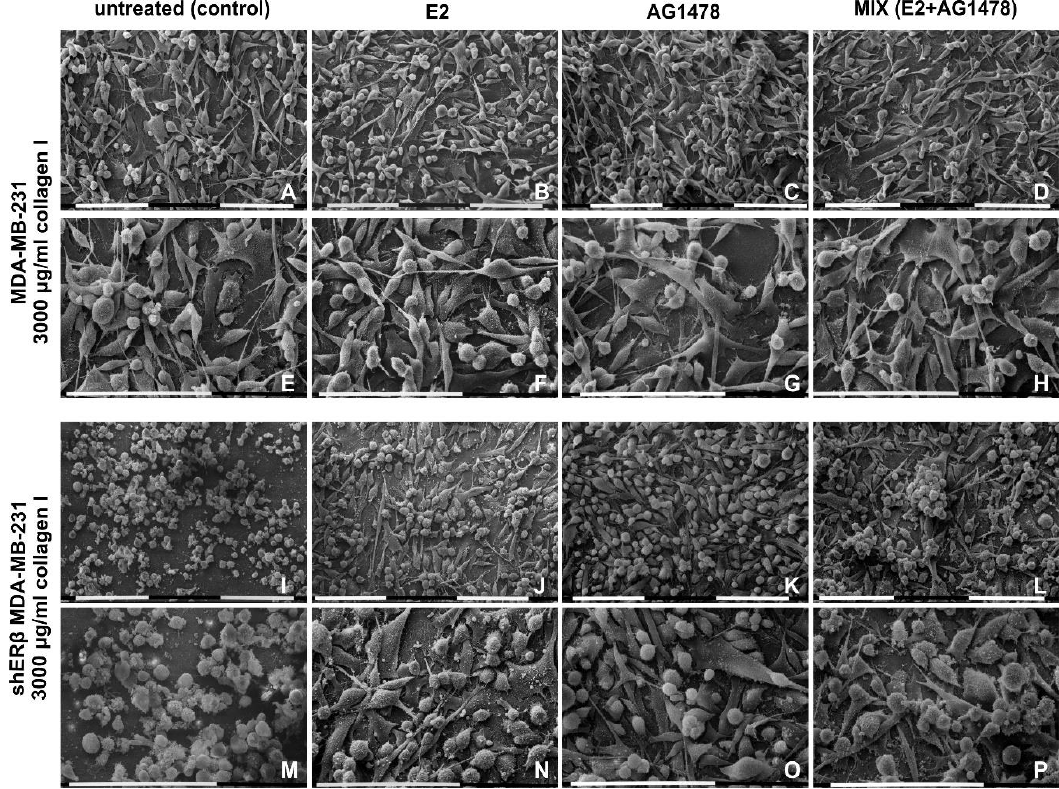
Figure 4. MDA-MB-231 and shERβ MDA-MB-231 cells cultured on Millipore filter covered by 3000 µg/mL type I collagen. ( A,E ) Untreated MDA-MB-231 cells include globular and elongated-fusiform phenotypes growing on flattened-polygonal cells strongly adhering to the collagen layer. Intercellular TNTs and long filopodia mainly originating from elongated-fusiform cells are visible. ( B , F ) When compared to the untreated samples, the same cells treated with E2 show a slight increase of globular and elongated-fusiform cells on flattened-polygonal ones adhering to the collagen substrate. Horizontal long conical filopodia and short intercellular TNTs are present. ( C , G ) MDA-MB-231 cells treated with AG1478 still exhibited globular and elongated-fusiform phenotypes on slightly increased flattened-polygonal cells. Long filopodia and TNTs are visible. ( D , H ) After a mix (E2 and AG1478) treatment, the MDA-MB-231 cells show a layer of flattened-polygonal cells adhering to the collagen substrate and covered by slightly decreased globular and elongated-fusiform cells with both long filopodia and TNTs. ( I , M ) Untreated shERβ MDA-MB-231 cells mainly include a globular cell phenotype. Cells appear mainly grouped and are occasionally connected by short intercellular TNTs; no filopodia are detectable. ( J , N ) When the same cells were treated with E2, mainly isolated globular and elongated-fusiform cells grew on a layer of flattened-polygonal cells. Cells developed EVs and microvilli, long filopodia and TNTs vs. control group. ( K , O ) shERβ MDA-MB-231 cells treated with AG1478 include many globular cells and few elongated-fusiform cells, all covering the flattened-polygonal ones. Cells are in very tight contact with each other, are uniformly distributed and show a smoother surface with few microvilli and fewer EVs, if compared to control and E2 groups. Long filopodia and TNTs were detectable. ( L , P ) After both E2 and AG 1478 treatments (mix group), shERB MDA-MB-231 cells included few elongated-fusiform- and many globular-shaped cells growing grouped in more than one layer on the flattened-polygonal ones. Filopodia are detectable. Bar = 0.1 mm.